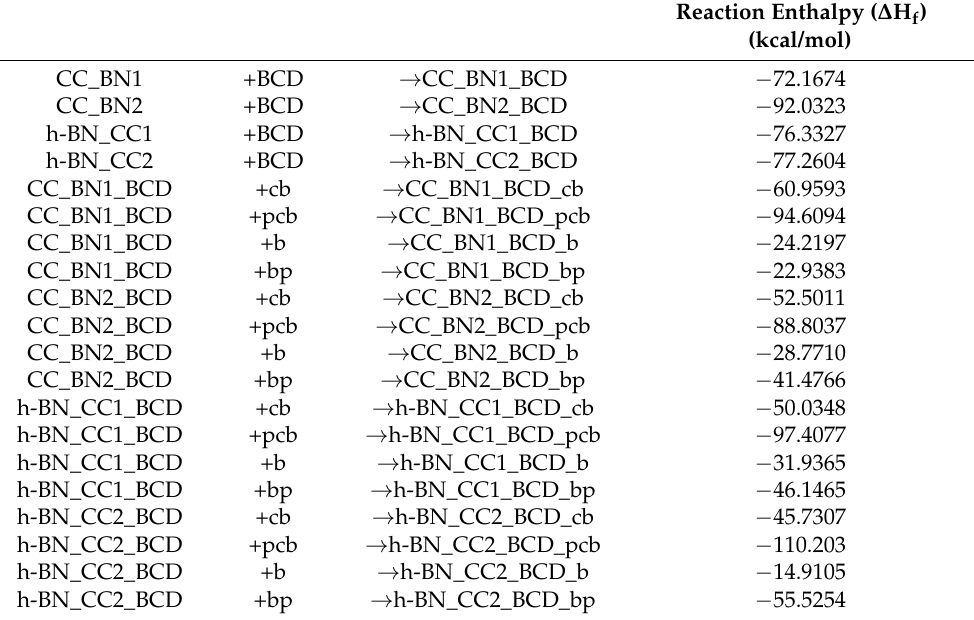
Table 1. Reaction enthalpy ( ∆ H f in kcal/mol) of hexachlorobenzene (cb), decachlorobiphenyl (pcb), benzene (b), and biphenyl (bp) adsorbed by the nano-systems of BN-doped graphene (CC-BN1 and CC-BN2) and carbon-doped hexagonal boron nitride (h-BN-CC1 and h-BN-CC2) decorated with beta-cyclodextrin